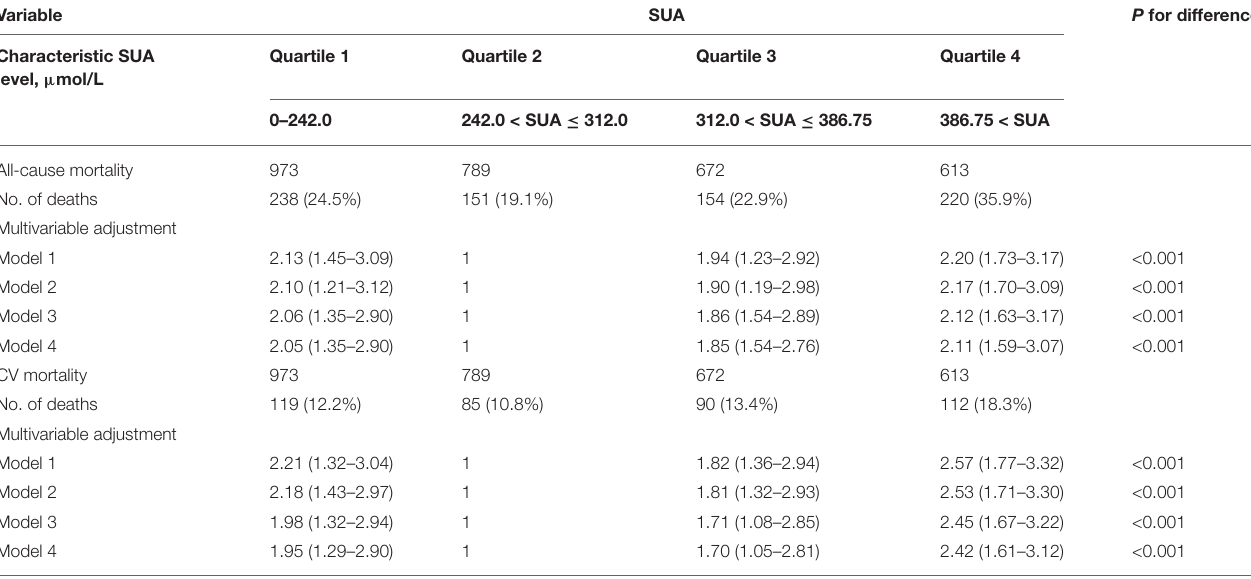
TABLE 2 | Adjusted hazard ratio for all-cause mortality and cardiovascular disease (CVD) mortality by Cox regression models according to serum uric acid level. Variable